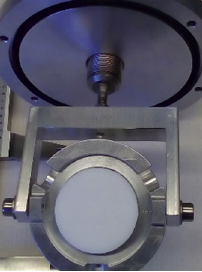
Fig. 3 The PTFE sample placed in the movable sample holder